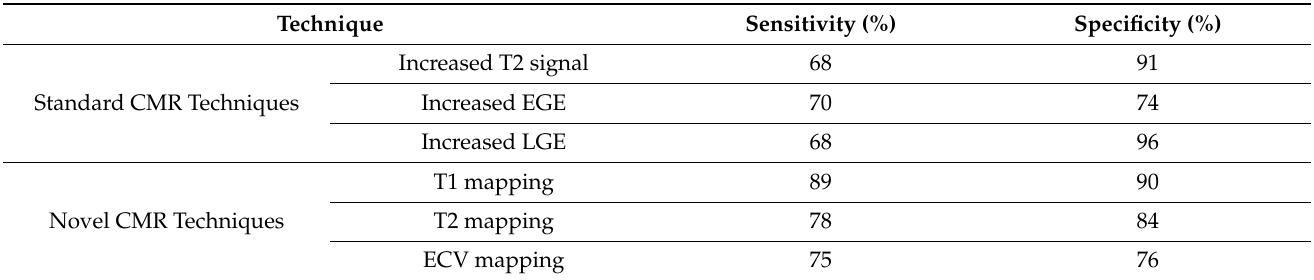
Figure 3. A case of myocarditis that was diagnosed using CMR based on the 2018 revised LLC. ( A ): T2-weighted image (T2 double inversion non-contrast) showing edema in the mid-myocardial segment of the anterolateral wall (non-ischemic distribution). ( B ) Short-axis and ( C ) 4-chamber view LGE images showing high signal intensity (SI) in a non-ischemic distribution in the midwall along with pericardial involvement on LGE imaging. LGE imaging taken months after treatment as seen in ( D , E ) when compared to ( B , C ), respectively, showing no myocardial scar seen on LGE with only evidence of pericardial fibrosis. Image courtesy of Neeraja Yedlapati, MD, FACC, FASE, FSCCT. Table 2. A comparison between standard versus novel CMR techniques showing a higher sensitivity of T1, T2, and ECV mapping compared to the standard CMR